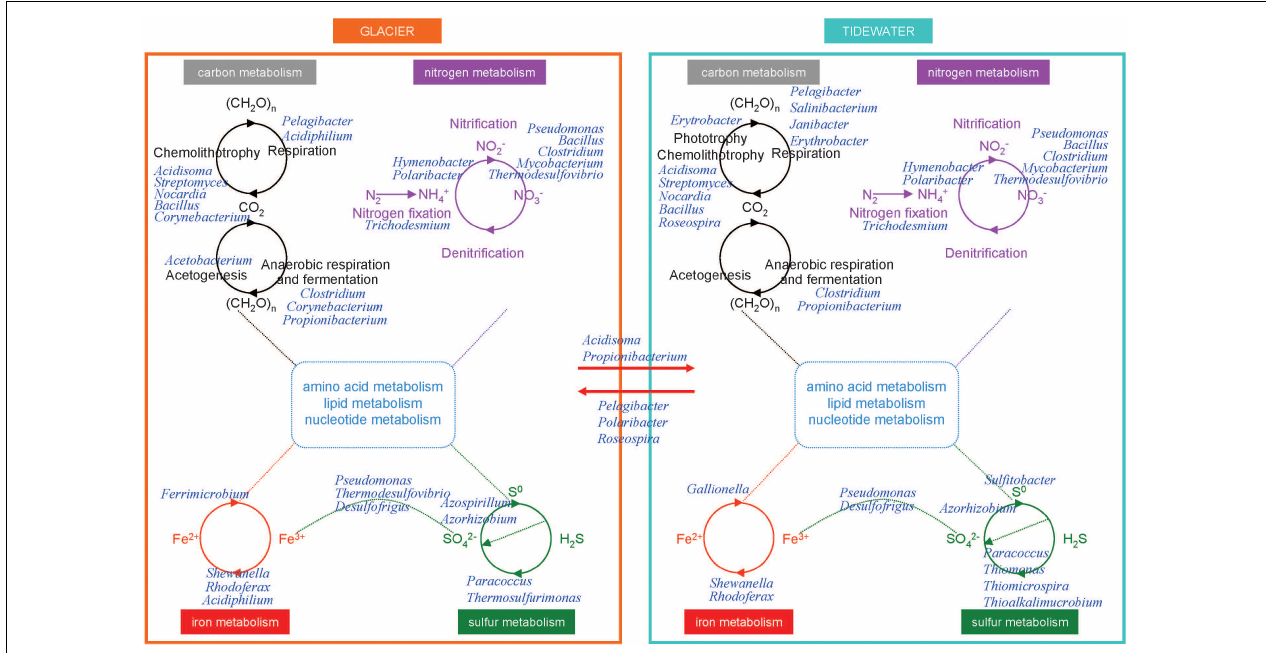
FIGURE 7 | Overview of the tentative interactions with the biogeochemical cycles in microorganisms from glaciers and tidewater samples. Microorganisms were identified by Illumina sequencing. Some key members of carbon, nitrogen, iron, and sulfur cycles in glacier (left) and tidewater samples (right) . They are represented at the genus